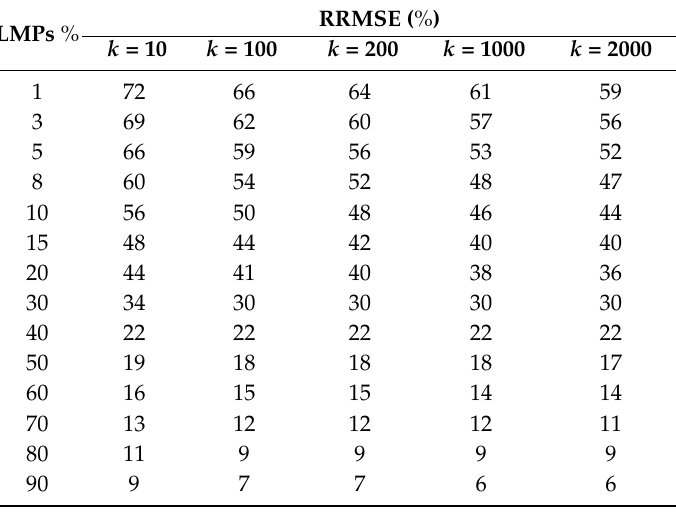
Table 5. RRMSE values using different number of particles in the PF for different